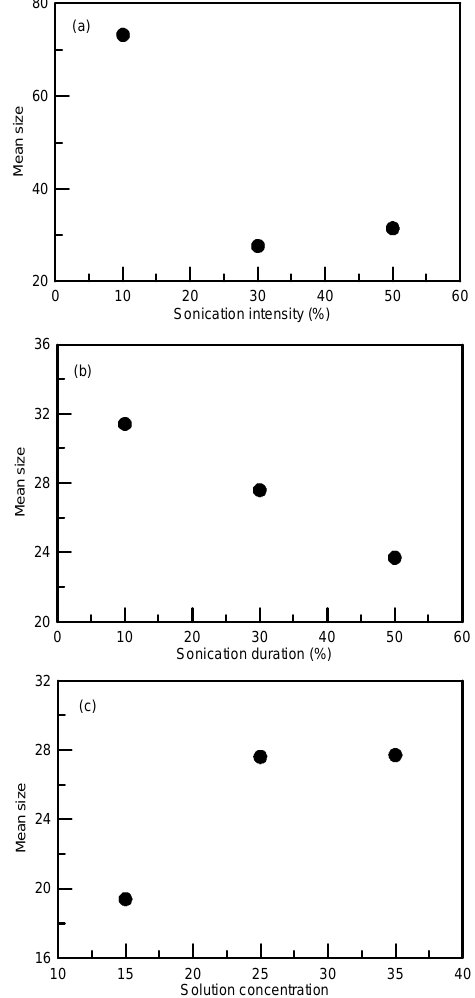
Figure 9. Illustration of the effect of the following operating parameters on the mean size of N ′ -(propan-2-ylidene)-isonicotinohydrazide: ( a ) sonication intensity; ( b ) sonication duration; and ( c ) solution concentration.